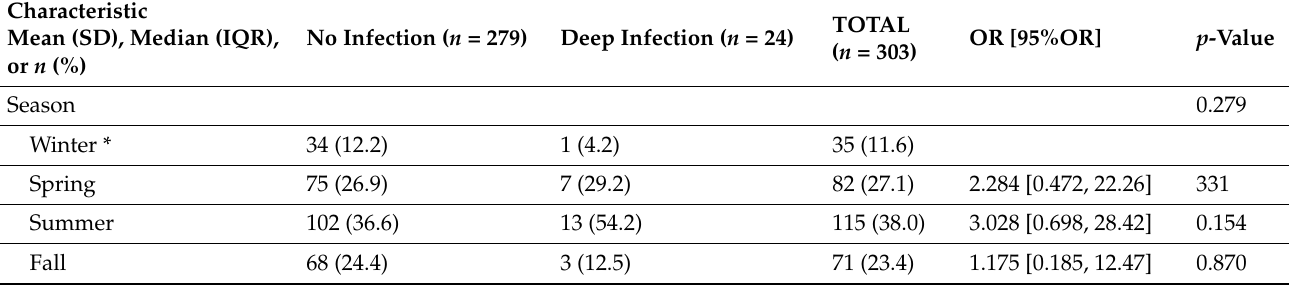
Table 3. Open Fracture and Injury Event